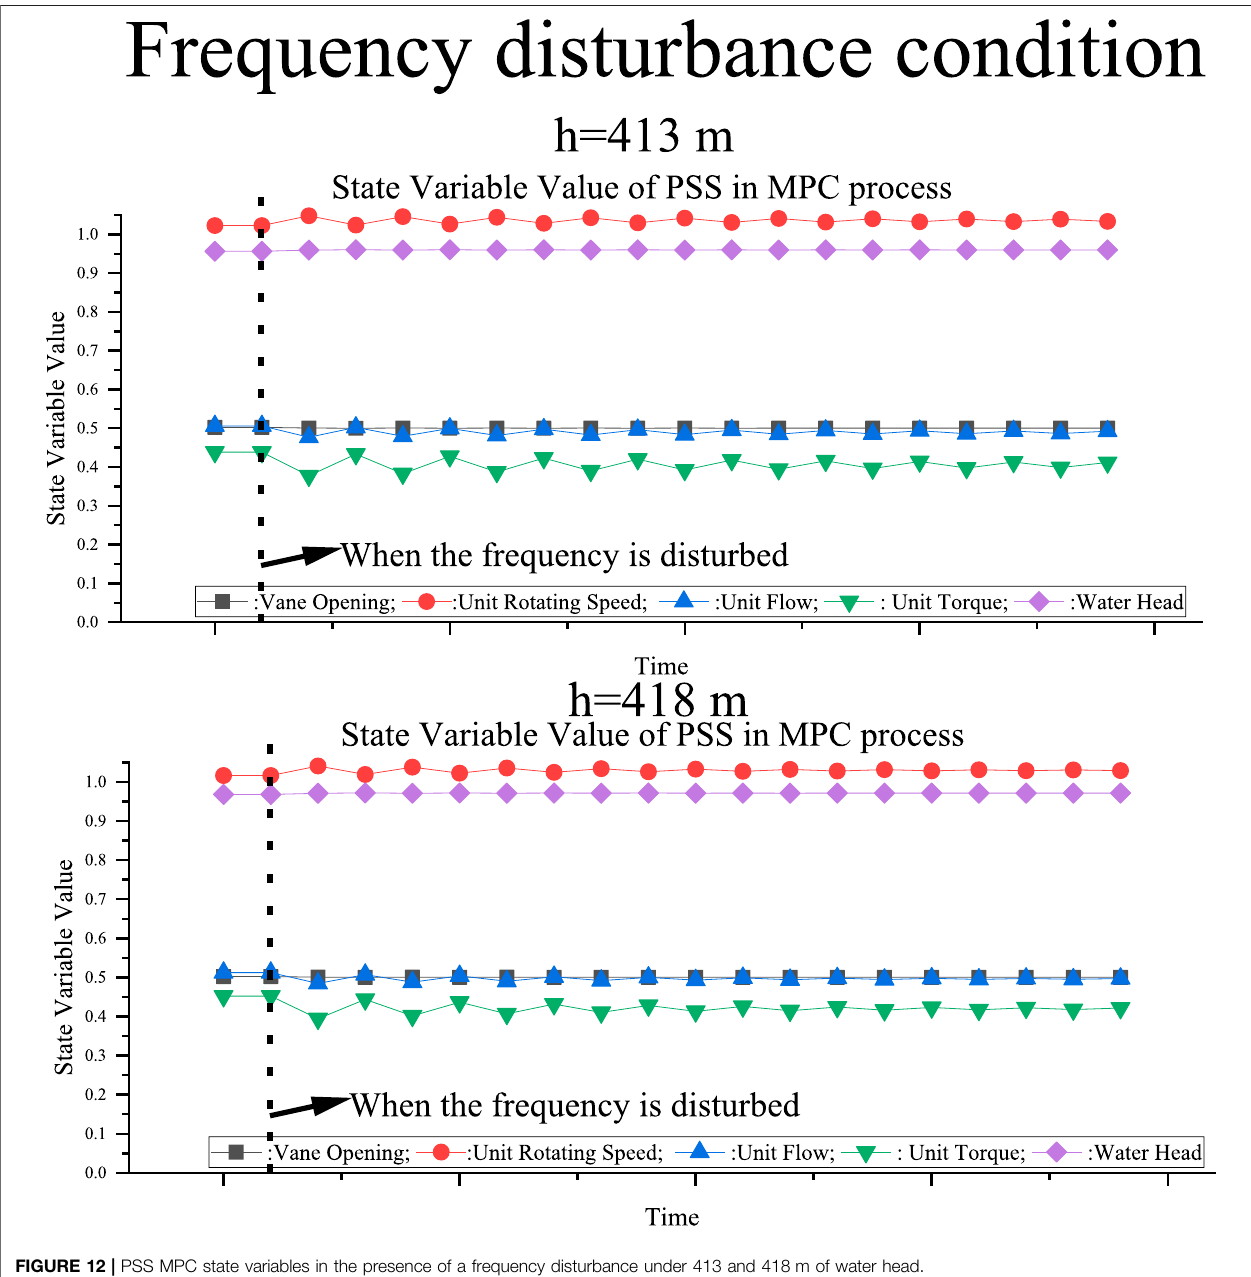
Frontiers in Energy Research |